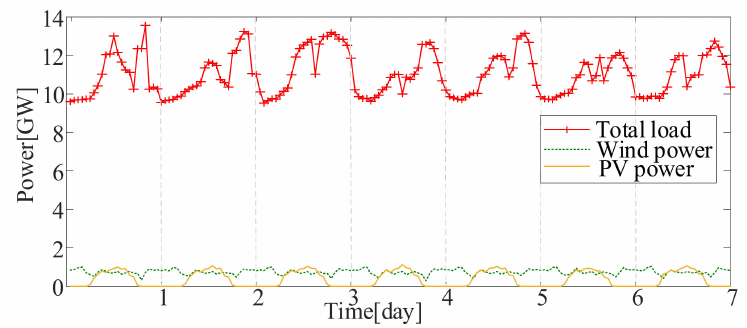
Figure 5. The prediction curves of total load, wind power and photovoltaic (PV)